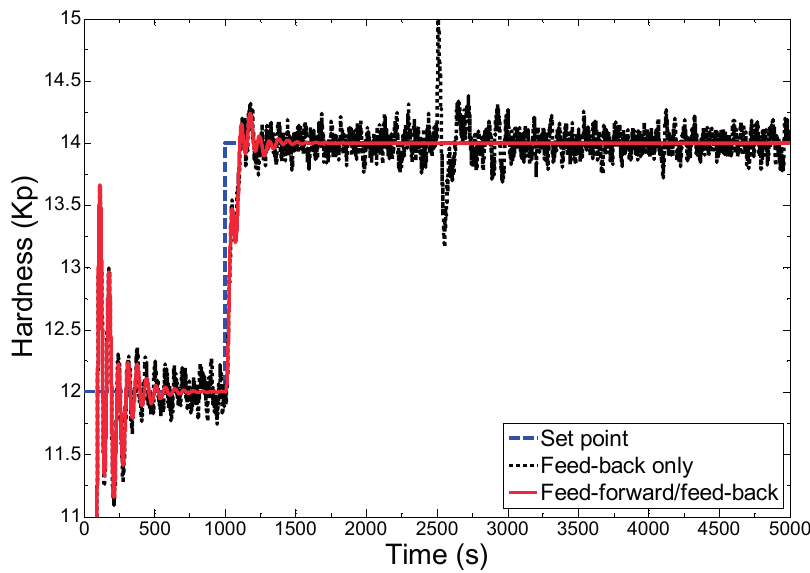
Figure 5. Comparison of combined feed-forward/feed-back control strategy with feed-back only control strategy for hardness control.